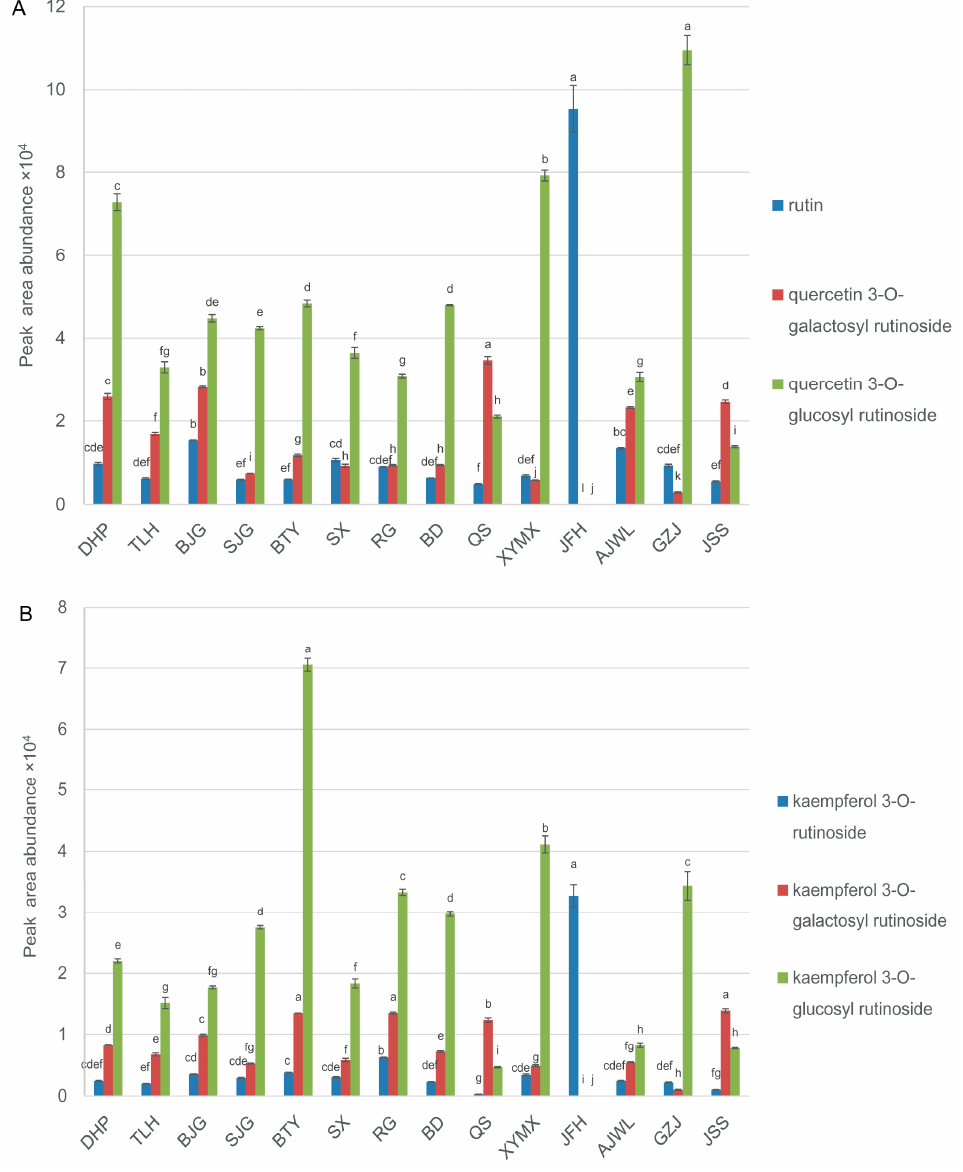
Figure 4. Mean peak area abundance values ( ± SD) of ( A ) some quercetin glycosides and ( B ) some kaempferol glycosides in leaves of 14 tea cultivars. Different letters on top of the vertical bars of the graph indicate significant differences among the samples, which were determined by Tukey’s HSD test at p < 0.05.